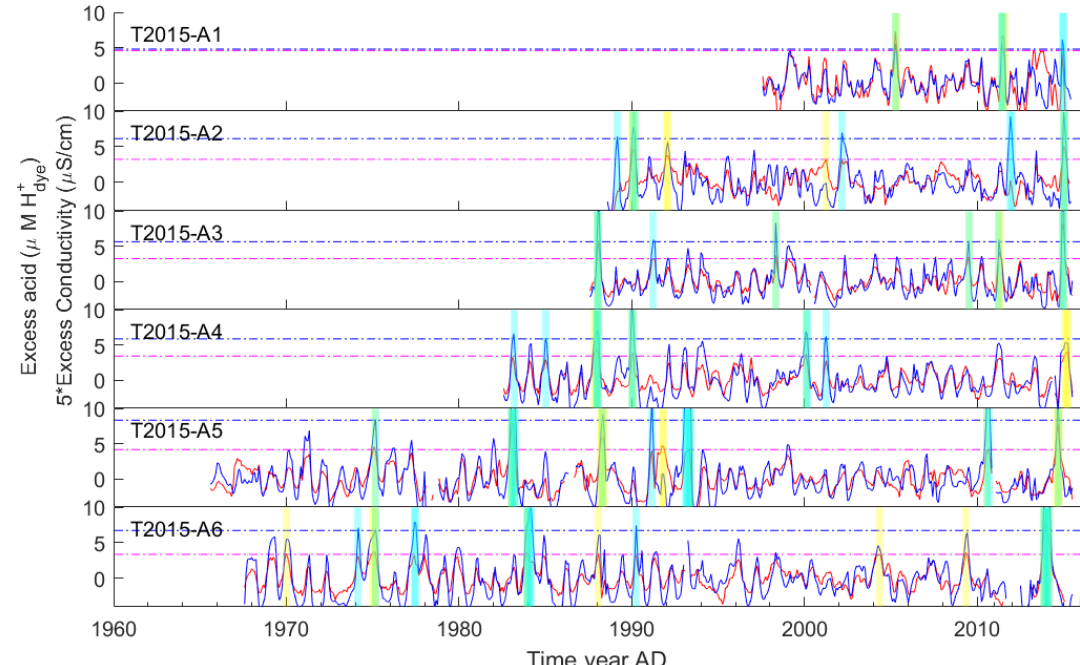
Figure 6. Excess acidity (red) and excess conductivity (blue) as compared to a 5-year running average. Note that the conductivity is scaled with a factor of 5. Dashed horizontal lines indicate the 97.5% quantile for conductivity (light blue), acidity (yellow) or both (green). Vertical bars indicate times exceeding 2 standard deviations for conductivity and acid compared to a 5-year running average in yellow and cyan, respectively; green indicates when these are observed in both. T2015-A1 through T2015-A6 are shown (from top to